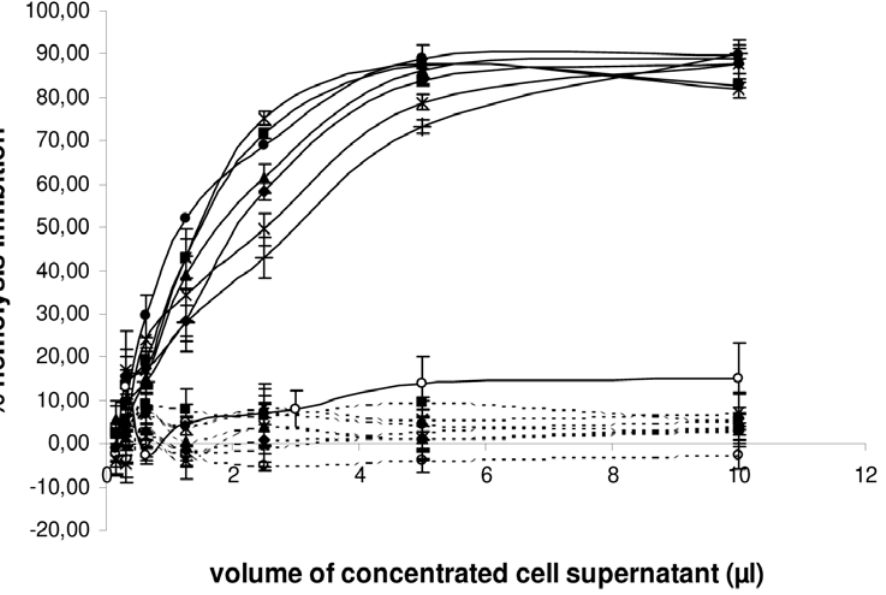
Figure 5. Effect of recombinant I.ricinusIxAC proteins on the alternative and classical pathways of complement activation . Assays of the alternative (AP, solid lines) and classical (CP, dashed lines) complement activation pathway were conducted in the presence of normalized amounts of recombinant I. ricinus IxACs produced in the supernatant of transfected 293T cells. Values for the percent inhibition of rabbit red blood cell lysis in the presence of human serum are indicated. The values are means 6 standard deviation of triplicates. RaHBP2 was used as negative control. Black diamond :IRAC I; black square:IRAC II; black triangle:IxAC-B1; cross:IxAC-B2; star:IxAC-B3; closed circle:IxAC-B4; Plus:IxAC-B5; open circle:RaHBP2.